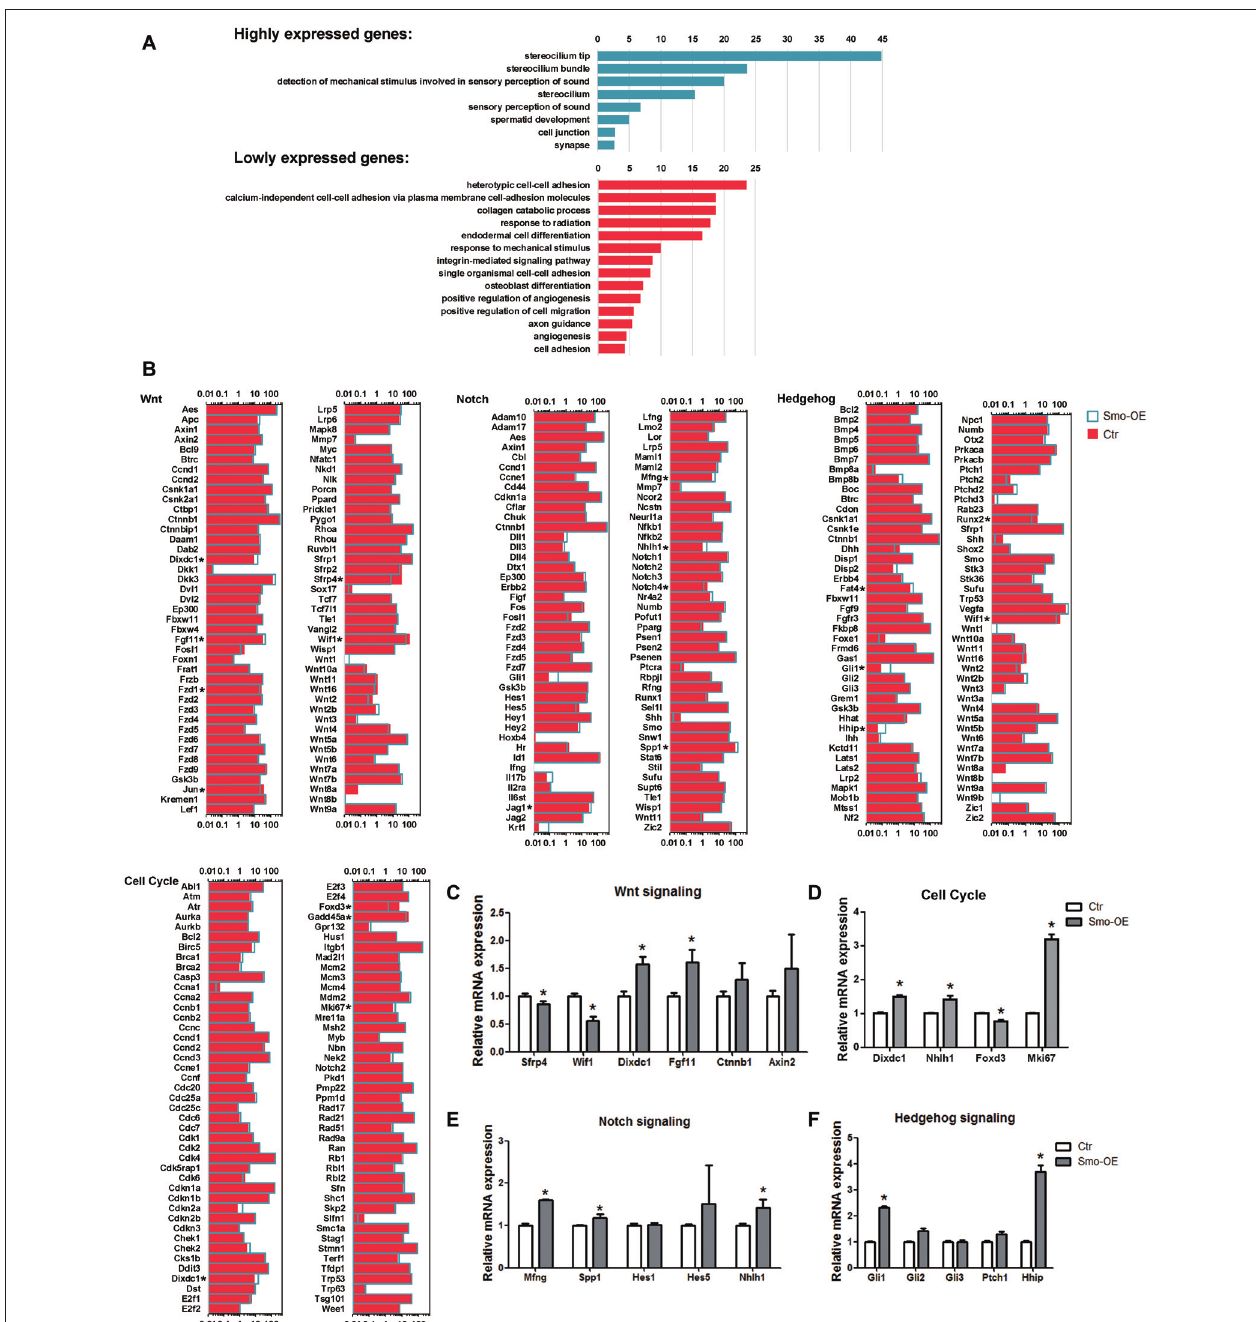
FIGURE 6 | Gene ontology and signaling pathway analysis of the genes that are differentially expressed in the Smo-OE and control cochlear epithelium. (A) Gene ontology of the genes that are differentially expressed in the Smo-OE and control cochlear epithelium. (B) Signaling pathway genes in the Smo-OE and control cochlear epithelium. (C) q-PCR analysis of Wnt signaling pathway genes. (D) q-PCR analysis of cell cycle genes. (E) q-PCR analysis of Notch signaling pathway genes. (F) q-PCR analysis of Hedgehog signaling pathway genes. ∗ p < 0.05.